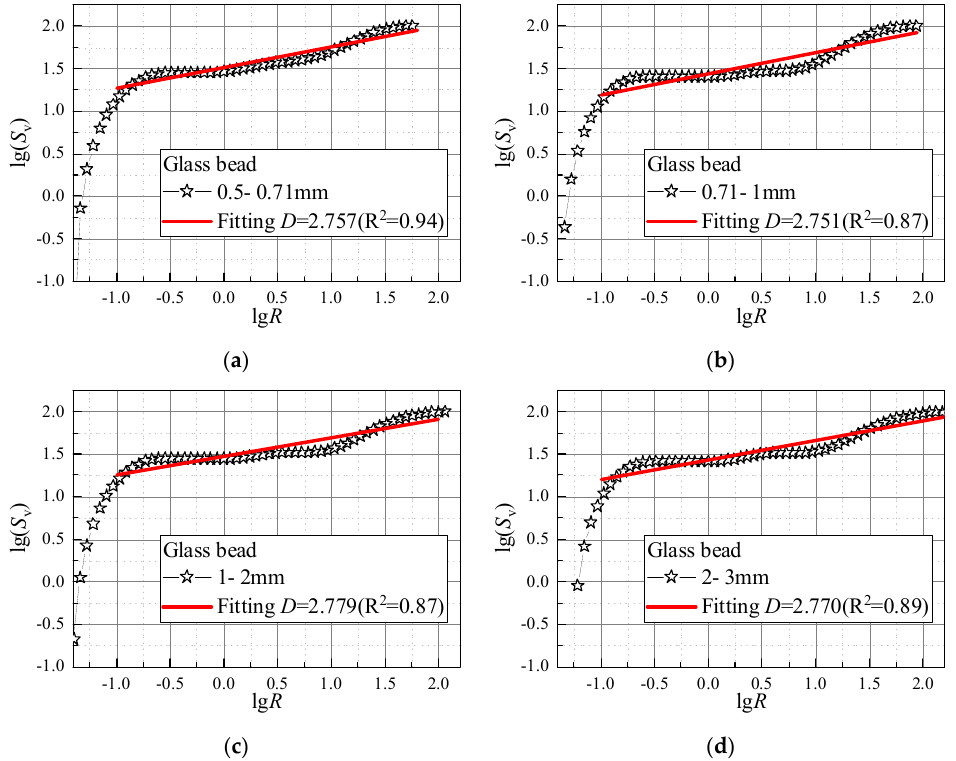
Figure 10. Determination of fractal dimension of glass bead with different grain sizes: ( a ) 0.5–0.71 mm; ( b ) 0.71–1 mm; ( c ) 1–2 mm; ( d ) 2–3